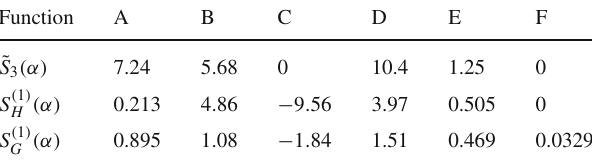
Table1 Resultforthedimensionlessleading-orderactionandthefunc- tional